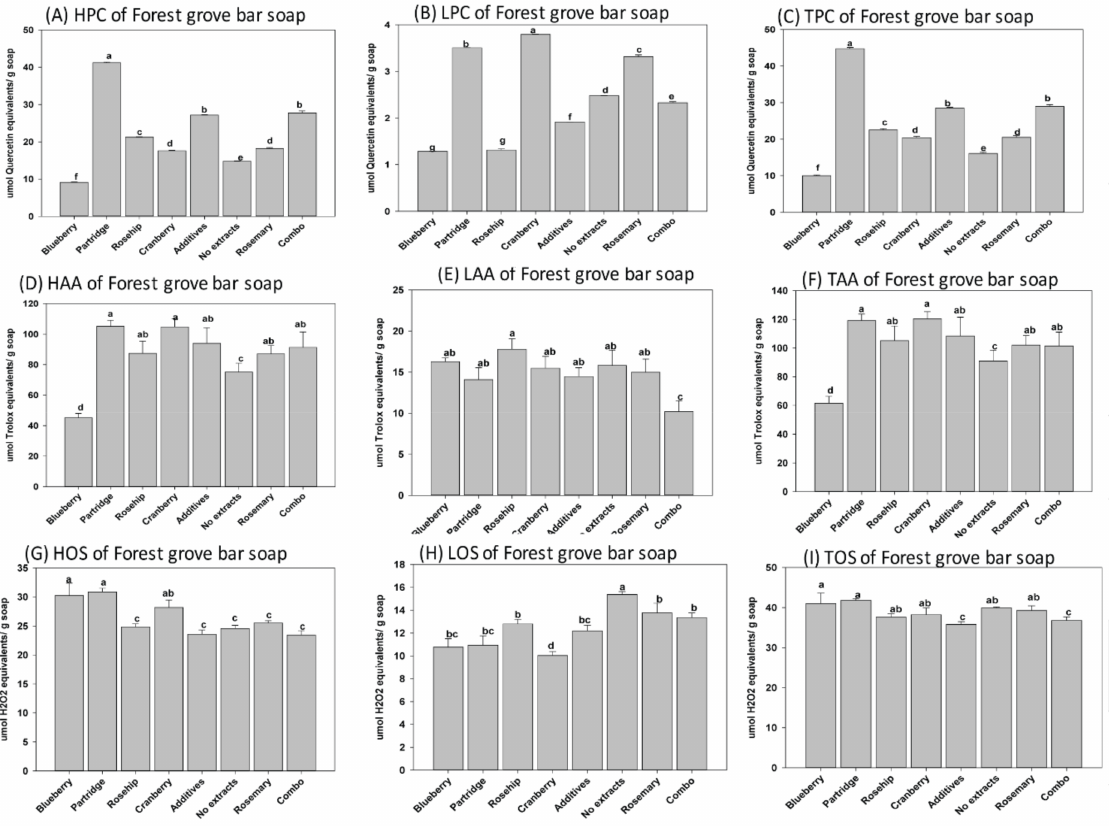
Figure3. Hydrophilic, lipophilic, andtotal( A – C )phenolics, ( D – F )antioxidants, and( G – I )oxidantstatus in the forest grove (FG) natural soaps following manufacturing by cold saponification. Bars represent the mean ± standard errors. Error bars with di ff erent letters (a–g) are significantly di ff erent among treatments at LSD = 0.05, n = 4 per experimental replicate. HPC = hydrophilic phenolic content, LPC = lipophilic phenolic content, TPC = total phenolic content, HOS = hydrophilic oxidant status, LOS = lipophilic oxidant status, TOS = total oxidant status, HAA = hydrophilic antioxidant activity, LAA = lipophilic antioxidant activity, and TAA = total antioxidant activity. Combo = 25% of each of the blueberry, cranberry, and partridge berry and rosehip